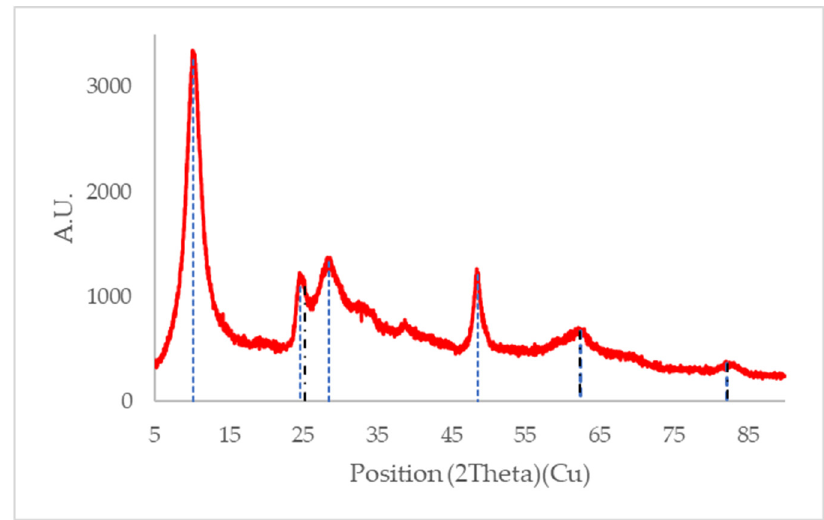
Figure 9. XRD pattern for SL400 without use. The blue dotted lines represent the peaks associated with titanates and the black dotted line represents the peaks associated with the anatase phase of TiO 2 .